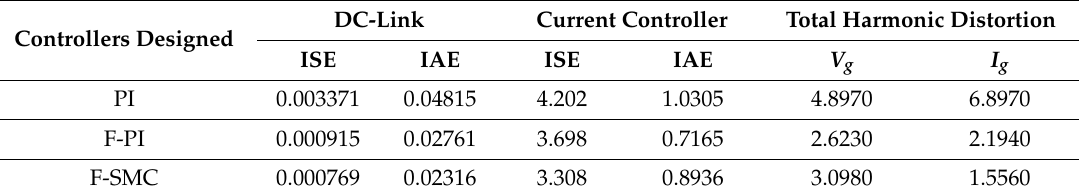
Table 3. Performance of the designed controllers without the feed-forward loop of PV